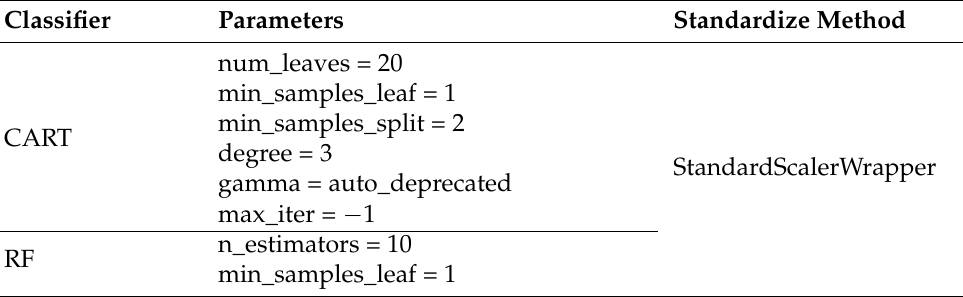
Table 1. Pixel-based classifiers and parameter